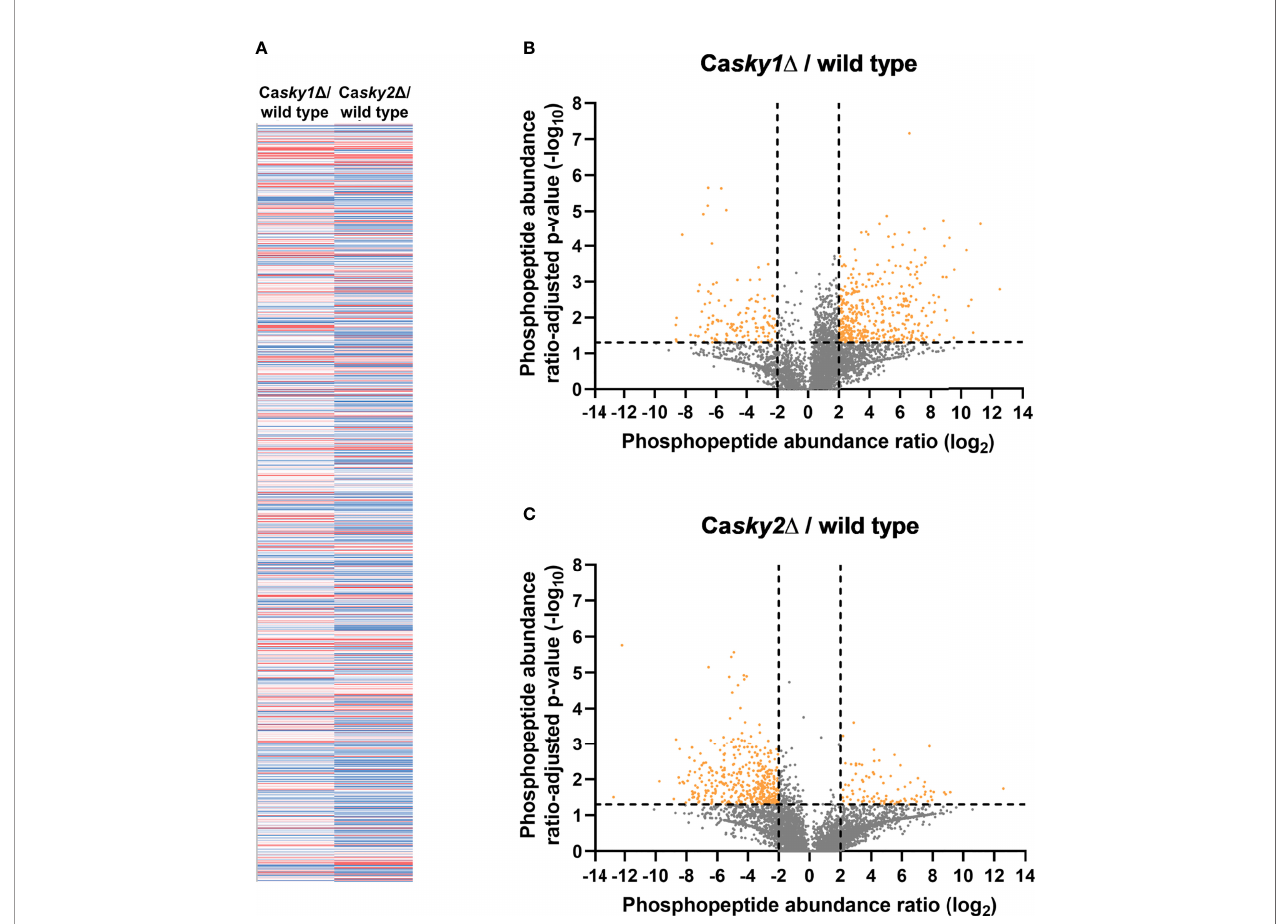
FIGURE 5 | Phosphoproteome analysis revealed a distinct set of putative substrates for C. albicans Sky1 and Sky2. YPD overnight cultures were adjusted to an optical density (OD 600 ) of 0.1 in YPD medium and incubated at 37°C for 4 h. Cells were harvested, lysed and proteins were tryptically digested, followed by phosphopeptide enrichment based on TiO2/ZrO2 resin (a non-enriched fraction served as reference). Three biological replicates were used per strain. (A) Heat map of all identi fi ed phosphopeptides (n=7243) by comparison of the fold change between sky1 D versus wild type (left) and sky2 D versus wild type (right) colored as follows: 10% quantile (blue), 50% quantile (white) and 90% quantile (red). (B, C) Volcano plots comparing the phosphopeptide abundance log2ratios (X axis) and the ratio-adjusted p-values as negative decade logarithm (Y axis) of all identi fi ed phosphopeptides for sky1 D versus wild type (B) and sky2 D versus wild type (C) . Highly signi fi cant changes are indicated as log2ratios < -2 and > 2 (4-fold change) and – log10 p-values > 1.3 (ratio adjusted p-value <